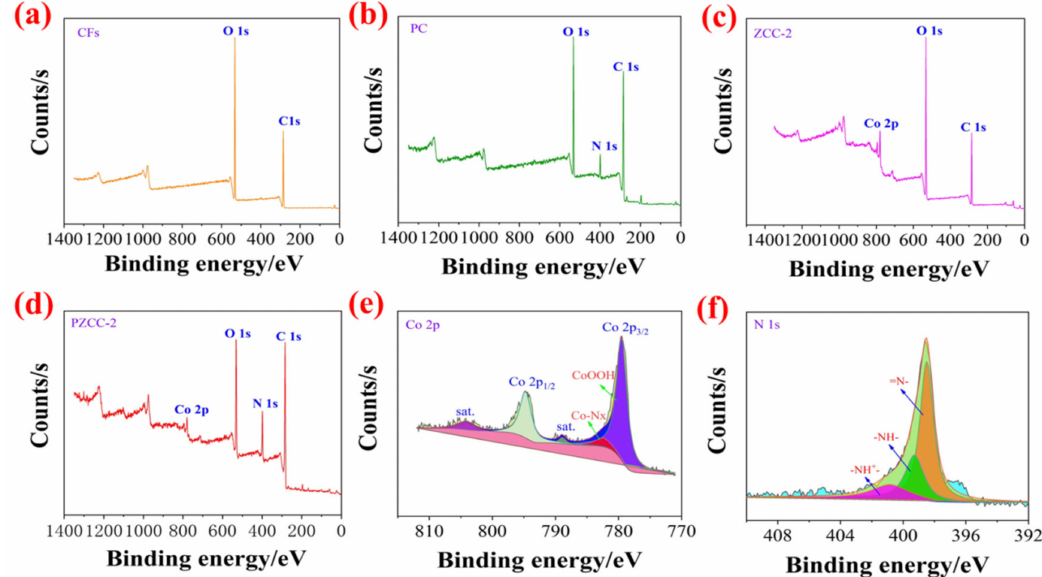
Figure 4. XPS survey spectrum of CFs ( a ), PC ( b ), ZCC-2 ( c ), and PZCC-2 ( d ). High-resolution XPS of Co 2p ( e ) and N 1s ( f ) based on ZCC-2 and